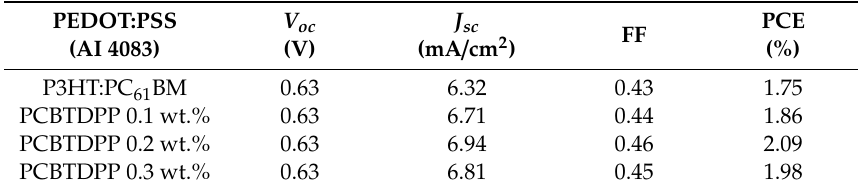
Table 1. Summary of photovoltaic (PV) performances of the devices based on low conductive PEDOT:PSS (AI 4083).